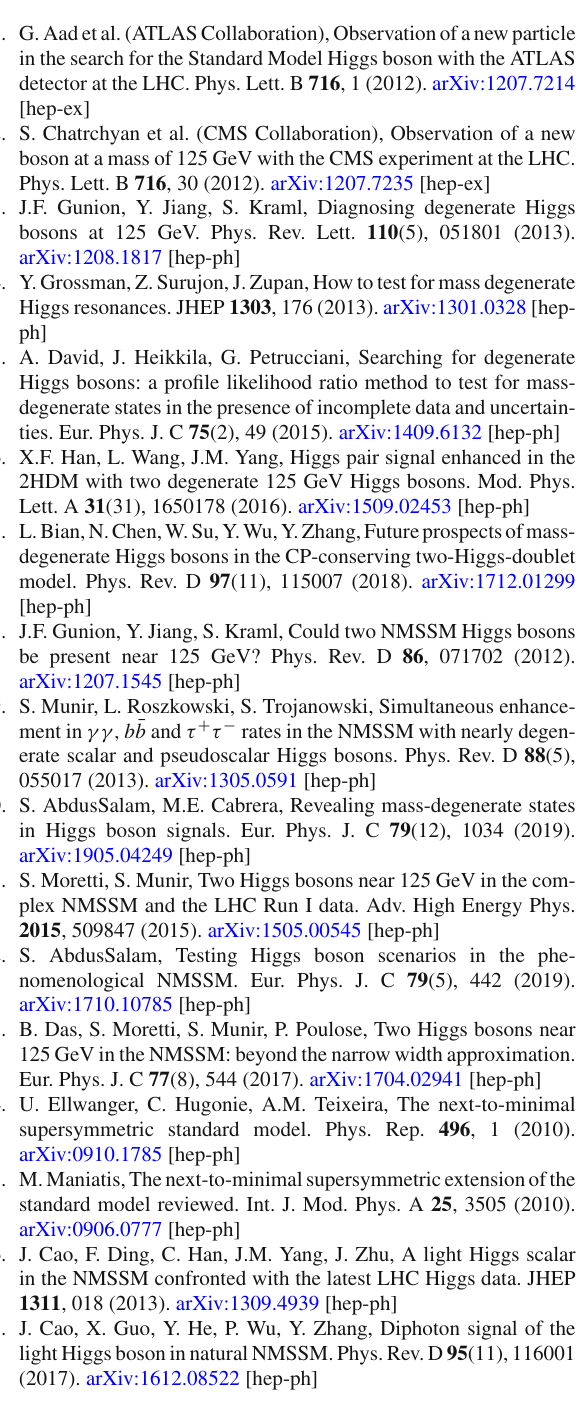
deviation of 3% (1%), the value of χ 2 is about 120 (100) in Fig. 3b. Figure4shows thefieldcomponents of H 1 and H 2 , respec- tively. For the left (right) upper corner samples, H 1 ( H 2 ) is dominated by singlet field S 3 and H 2 ( H 1 ) consists mainly of SM-like Higgs field S 2 . Their corresponding Higgs signal characters D i ( i = 1 , 2 , 3 ) are around one, which stands for the singlet dominated Higgs make little contribution to the Higgs signal. But for the middle samples, the mixing between S 2 and S 3 fields is large, both H 1 and H 2 have relatively large components of SM-like Higgs filed S 2 and their double ratios D i ( i = 1 , 2 , 3 ) slightly deviate from one. That is to say, the observed Higgs signal may be due to the contributions from the nearly mass-degenerate Higgs bosons near